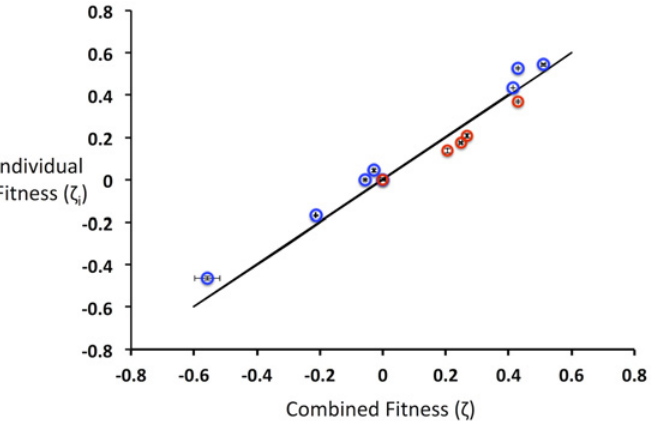
Fig 8. Experimental validation of growth rate normalization relation. E. coli harboring 11 different plasmids driving differential eGFP levels were grown in a single population or in two separate populations. The fitness from the separate populations (represented by blue and red open circles) and combined populations were evaluated and compared. Error bars represent one standard deviation from two independent experiments. The solid black line represents the theoretically ideal relationship between individual and combined